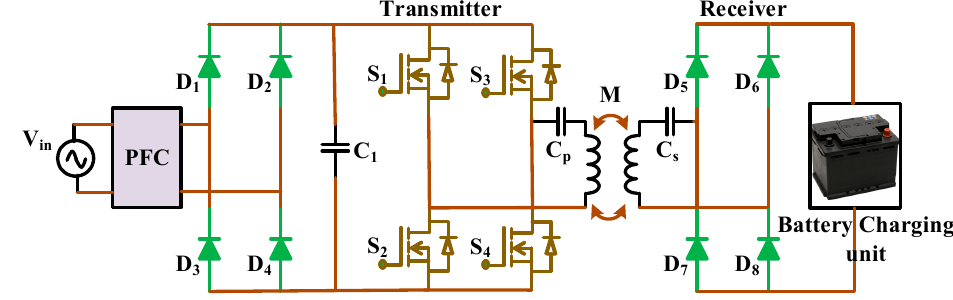
Figure 2. Resonant power inductive transfer topology.